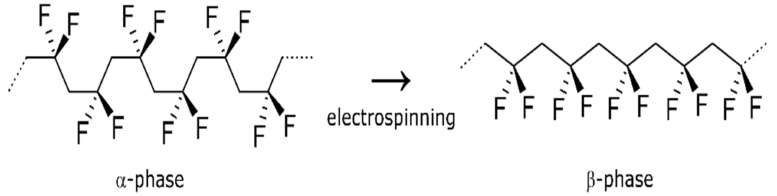
Figure 5. AFM of surface for pure PVDF nanofibrous membranes ( a ) fixed-point spinning ( b ) sweeping spinning and ( c ) fixed-point spinning and drying at 100 ◦ C.